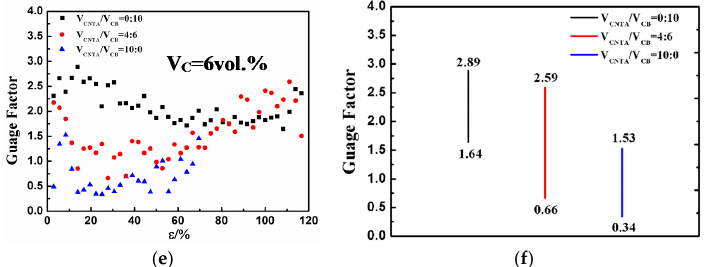
Figure 3. Gauge factor as a function of strain: ( a ) 1.5 vol %, ( c ) 3 vol % and ( e ) 6 vol %; range of sensitivity: ( b ) 1.5 vol %, ( d ) 3 vol % and ( f ) 6 vol %.